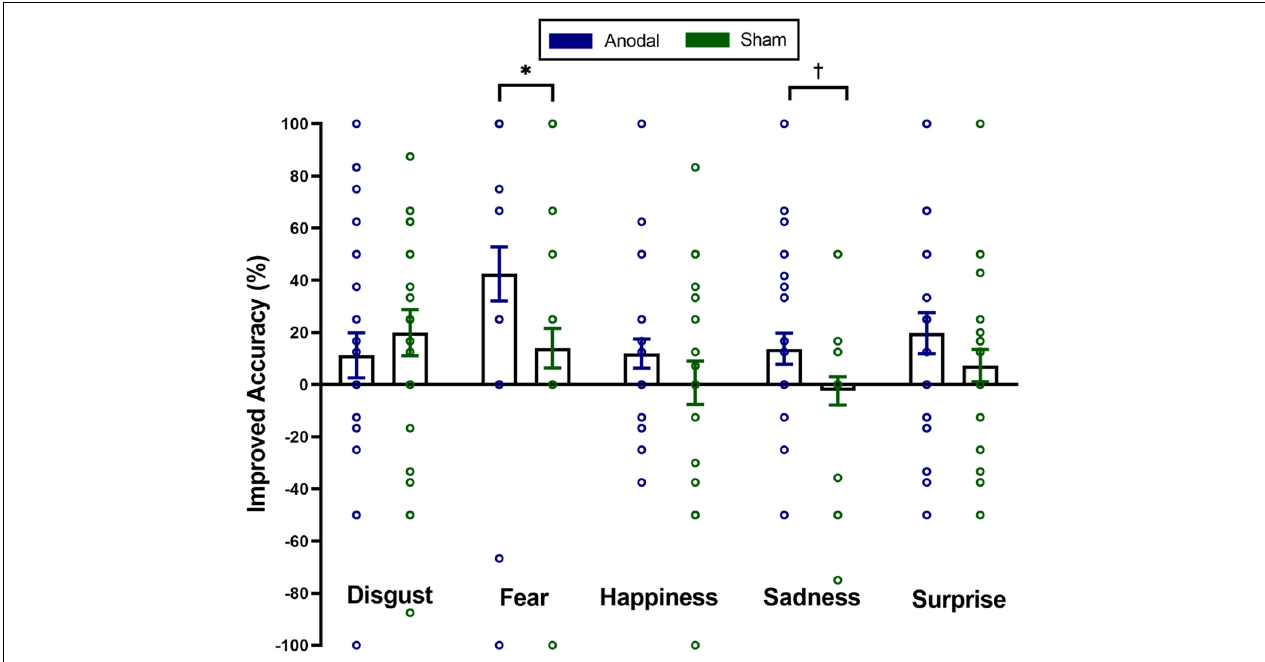
FIGURE 3 | Mean improved accuracy on distinct emotions of spontaneous micro-expressions for anodal and sham group in the first visit. Comparisons of the differences of distinct emotions between the two groups showed that the anodal group improved more than the sham group on spontaneous micro-expressions of fear and sadness. The significance levels are marked by different symbols. “ ∗ ” and “ † ” indicate p < 0.05 and p < 0.1 (two-tailed), respectively. Error bars represent standard error of mean (SEM). TABLE 2 | Correlations between empathic traits and mean improved accuracy of overall spontaneous micro-expressions, and mean improved accuracy of spontaneous micro-expression of fear and sadness in the anodal and sham group. Perspective taking Fantasy Empathy concern Personal